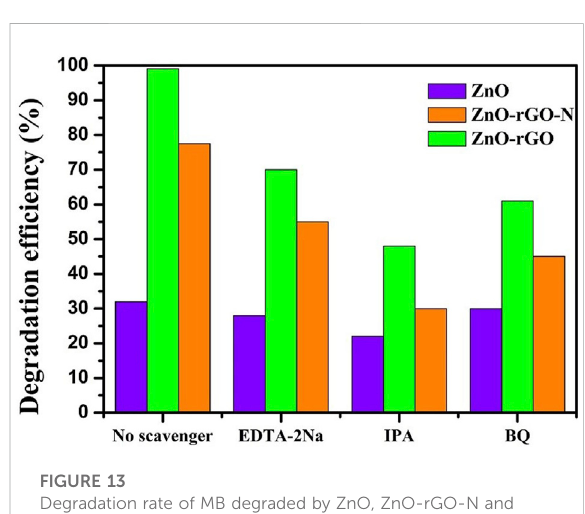
FIGURE 13 Degradation rate of MB degraded by ZnO, ZnO-rGO-N and ZnO-rGO Photocatalysts in the presence of capture